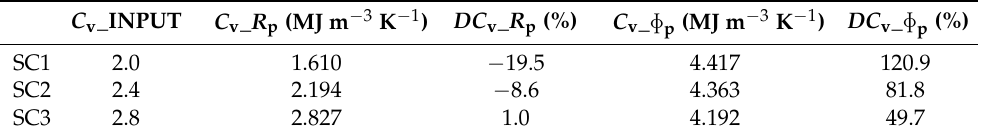
Table 5. Heat capacity deduced with TD from Table 4 and TC from the cooling period with deviations from the input value.